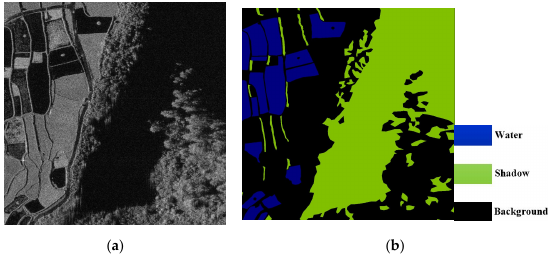
Figure 6. An example of Synthetic Aperture Radar (SAR) datasets. ( a ) SAR image. ( b ) Ground